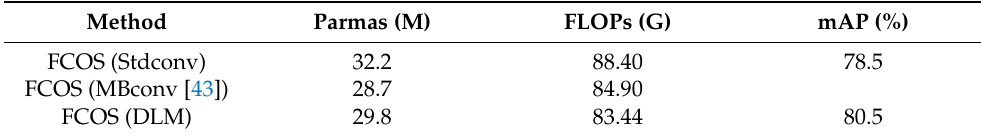
Table 5. Ablation study of the proposed module.